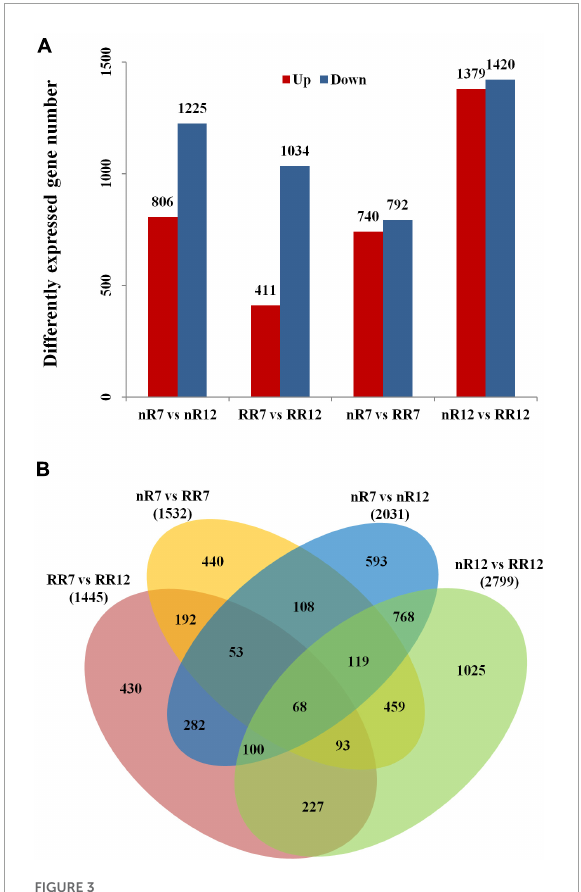
FIGURE3 Differentially expressed gene number analysis. (A) Differentially expressed gene numbers between different comparison groups (nR7 vs. nR 12, RR7 vs. RR12, nR7 vs. RR7, and nR7 vs. RR12). The annotations of up and down mean the number of significantly up-regulated or down-regulated genes. (B) Mutual and unique differentially expressed genes between different comparison groups (nR7 vs. nR 12, RR7 vs. RR12, nR7 vs. RR7, and nR7 vs. RR12). nR7, RR7, nR12, and RR12 represent the 70 DAP and 125 DAP sampling points under nR and RR